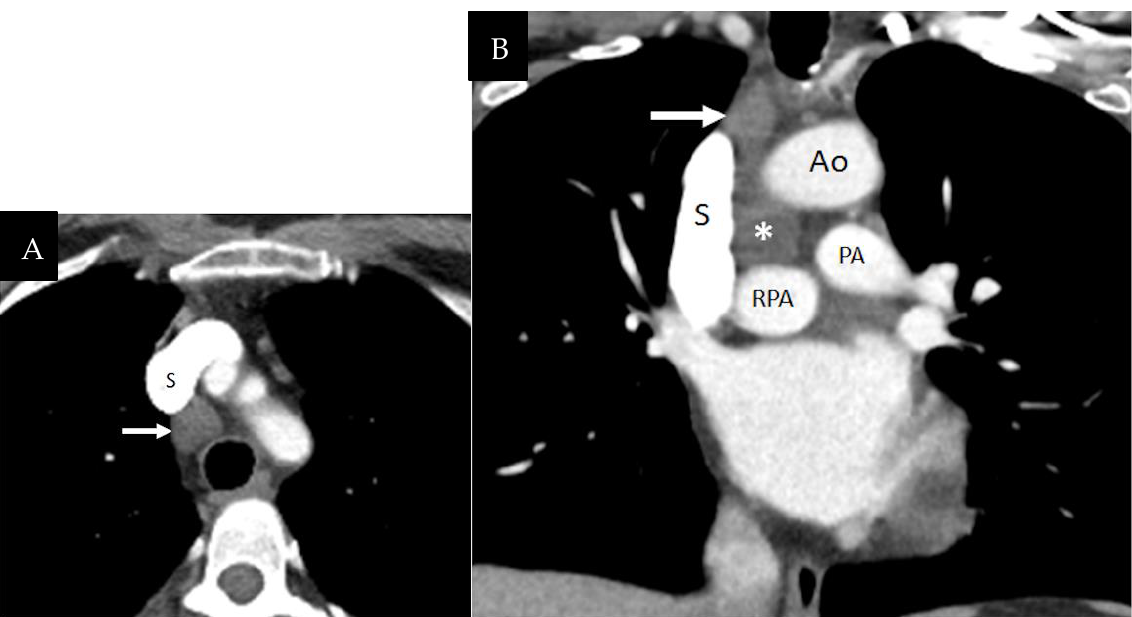
Figure 3. High-riding superior pericardial recess. 66 year-old woman with cervical cancer. ( A ) Con- trast-enhanced axial CT at the level of superior vena cava origin shows a cystic structure (arrow) at the right paratracheal region. ( B ) Coronal reformation demonstrates contiguity of the cystic struc- ture (arrow) with the superior pericardial recess (*) of transverse sinus. This “high - riding” variant can be misinterpreted as adenopathy when fluid attenuation and contiguity with the superior peri- cardial recess are not recognized. Ao = ascending aorta, PA = pulmonary artery, RPA = right pul- monary artery, S = superior vena cava. Reprinted from Shroff, G.S et al. Pitfalls in oncologic imaging of the pericardium on CT and PET/CT [4].